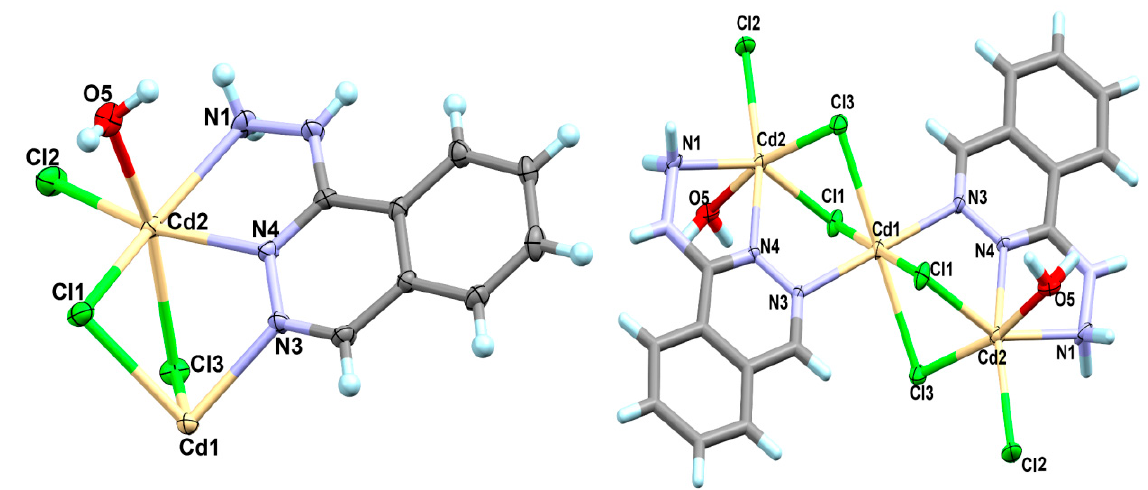
Figure 9. Asymetric unit ( left ) and complete trinuclear complex unit ( right ) with atom numbering for 3 .